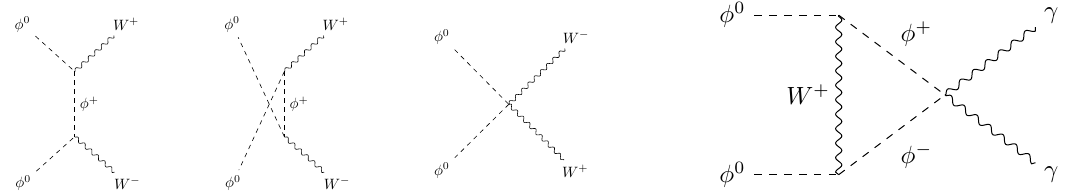
Figure 4: Representative Feynman diagrams for dark matter annihilation into W + W − at tree level (left), or into two mono-energetic photons at loop level